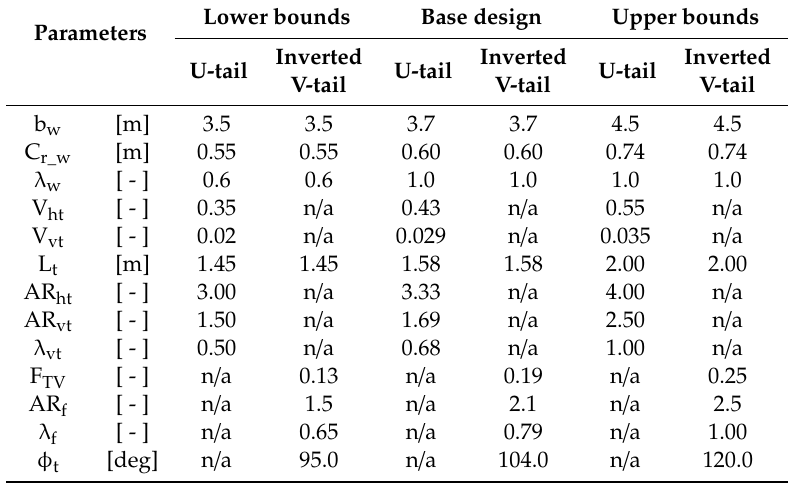
Table 1. Design variables and their upper and lower bounds for Aegis UAV configurations. Lower bounds Base Parameters